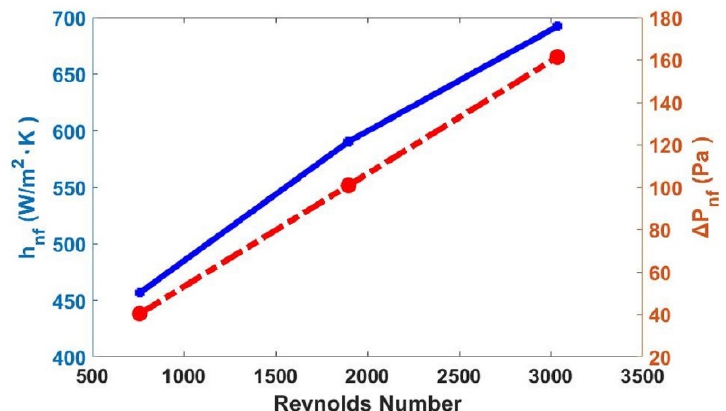
Figure 14. Heat transfer coefficient and pressure drop versus Reynolds number (blue solid line represents heat transfer coefficient and red dash-dotted line represents pressure drop).